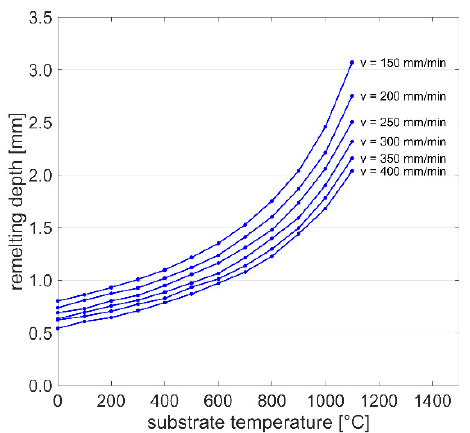
Figure 10. Remelting depth as a function of substrate temperature and scanning speed with constant laser power of 1000 W, obtained by the heat conduction model. laser power of 1000 W, obtained by the heat conduction